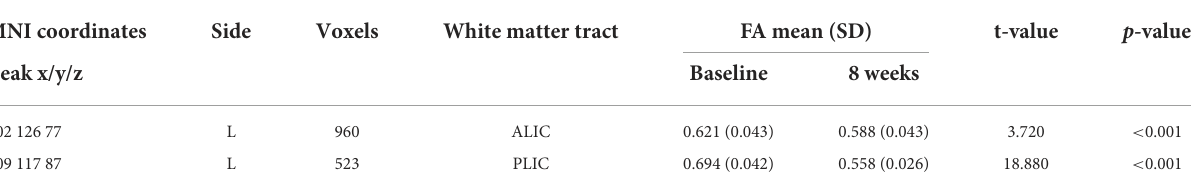
TABLE 3 Main regions showing FA alterations in patients with MMD (clusters > 50